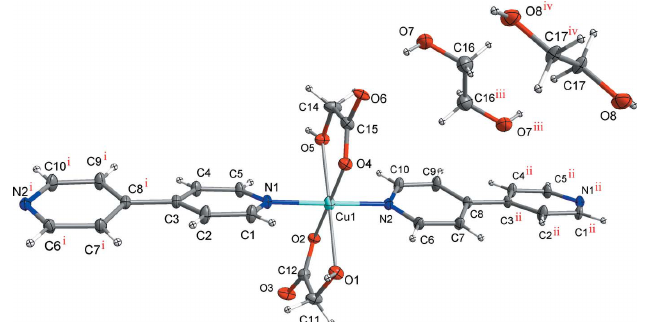
Figure 3 Two-dimensional supramolecular structure of the title polymer, formed by O—H (cid:2)(cid:2)(cid:2) O hydrogen bonds [shown as red or green dashed lines; symmetry codes: (iv) (cid:5) x + 1, (cid:5) y + 1, (cid:5) z ; (v) (cid:5) x + 1, (cid:5) y , (cid:5) z + 1; (vi) (cid:5) x + 1, (cid:5) y , (cid:5) z + 2].